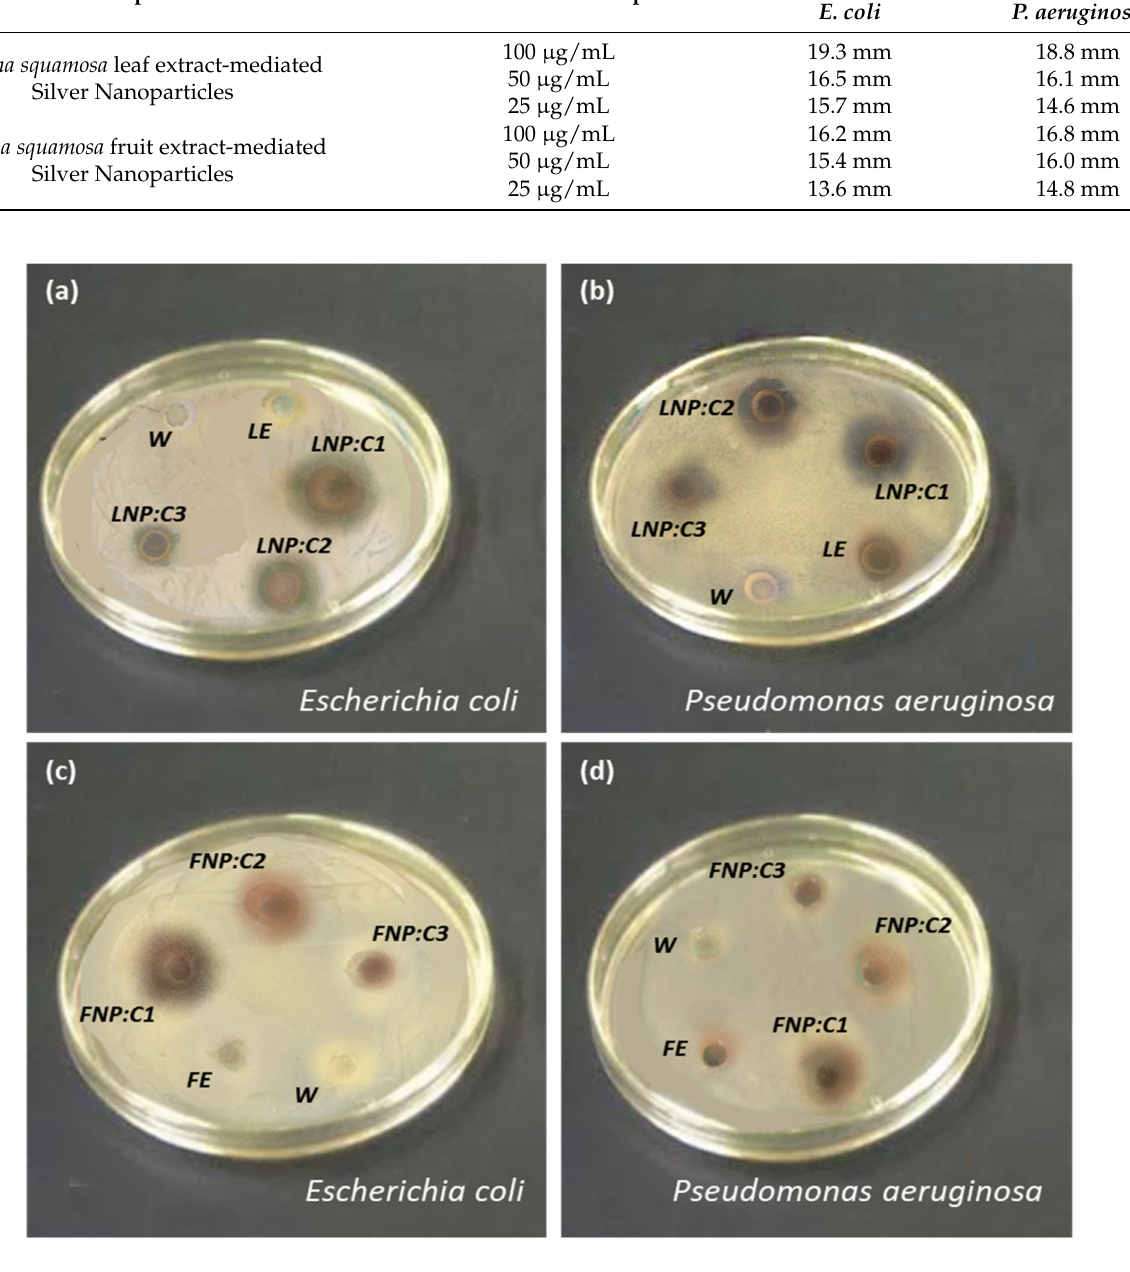
Figure 8. Antibacterial activity of Annona squamosa ( a , b ) leaf extract and mediated AgNPs against E. coli , P. aeruginosa , ( c , d ) fruit extract, and mediated AgNPs against E. coli , P. aerugi- nosa ; where, W = water; LE = leaf extract; FE = fruit extract; LNP = leaf extract-mediated Ag- NPs; FNP = fruit extract-mediated AgNPs. C = concentration; C1 = 100 µ g/mL, C2 = 50 µ g/mL, C3 = 25 µ g/mL,